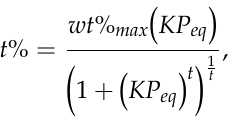
Table 2. Töth equation fitting parameters for the activated samples.